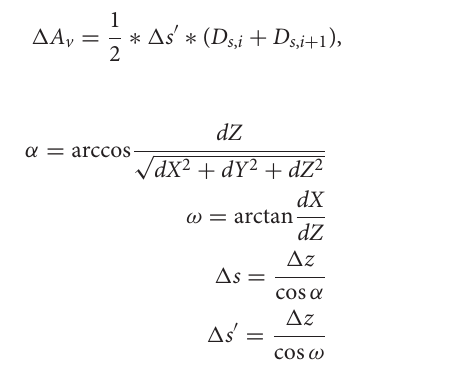
TABLE 3 | Frontal area calculation for all the branches of class 1 ( D B class 2 ( 20 mm < D B < 50 mm), class 3 ( D B